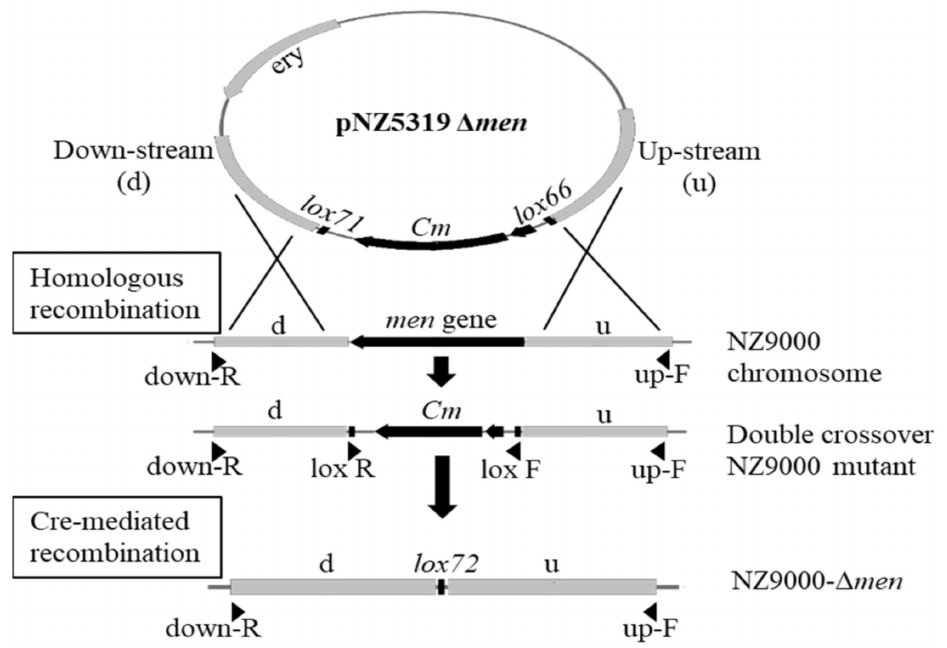
Figure 1. Construction of double-crossover men-gene replacement strains of L. lactis NZ9000 and subsequent Cre-lox-mediated selectable marker removal result in the L. lactis deletion strains (NZ9000- ∆ men). After transformation with either of the pNZ5319 knockout constructs, double crossover events result in the replacement of the target gene (men: menA , menB , menE , or menG ) by the lox66- P32-cm-lox71 cassette. The cm-cassette is later removed by Cre-mediated recombination, resulting in non-functional lox72